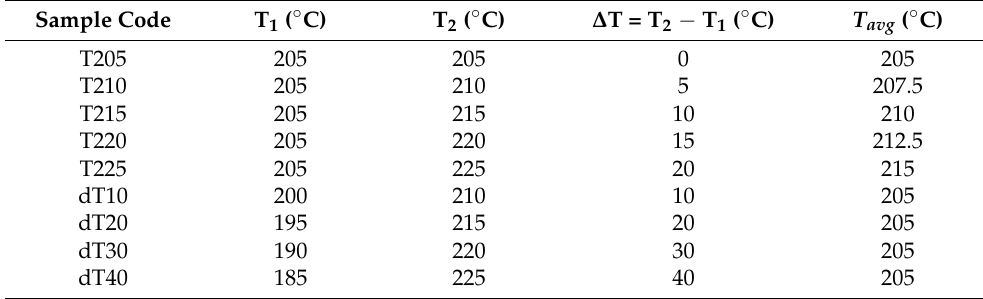
Table 1. The temperatures and codes of the samples